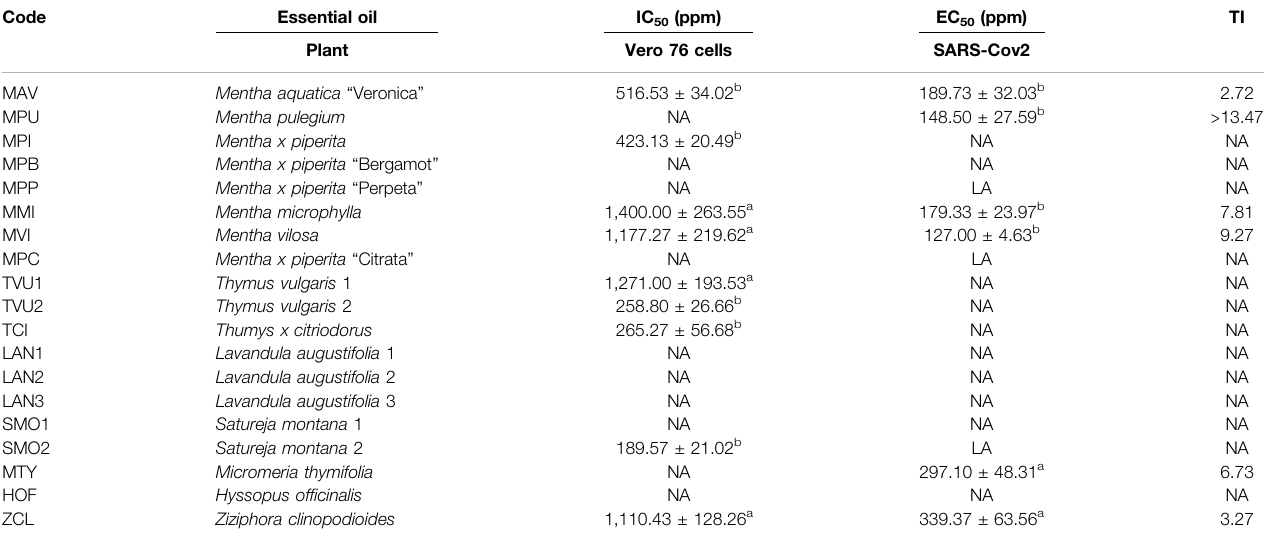
TABLE 3 | Cytotoxic and antiviral activity of essential oils. Code